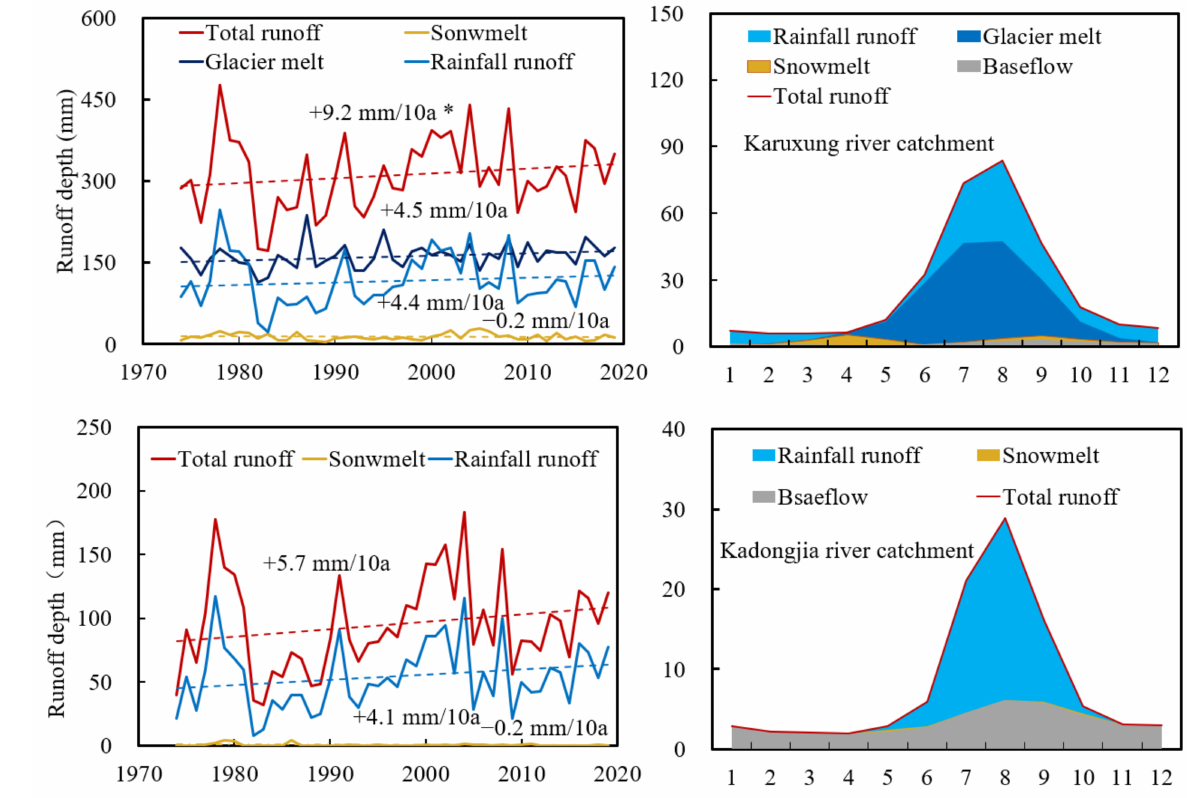
Figure 10. The changing trends of the total runoff and its components in the glacial region and non-glacial region from 1974 to 2019 (*: p < 0.05).